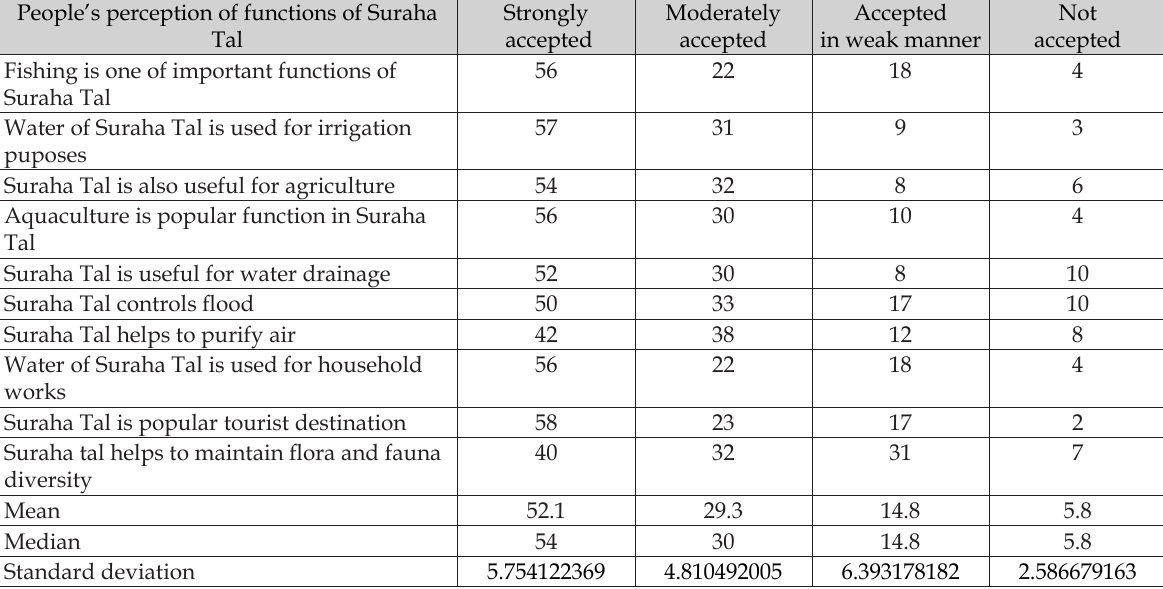
Table 5. Major functions of Suraha Tal Wetland. People’s perception of functions of